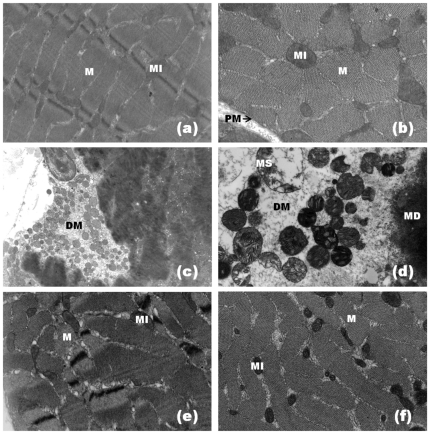
Electron micrographs of mouse diaphragm muscle.Control muscle (a, b) shows normal morphology with plasma membrane (PM), myofibrils (M) and mitochondria (MI). Muscle exposed to PrTX-I (c, d) presents fibers with myofibril disorganization (MD), cytoplasmic areas devoid of myofibrils (DM) and mitochondrial swelling with reduced or ruptured cristae (MS). Muscle exposed to PrTX-I pre-incubated with RA (e, f) shows normal fiber aspect. Note myofibrils (M) and mitochondria (MI) aspects.